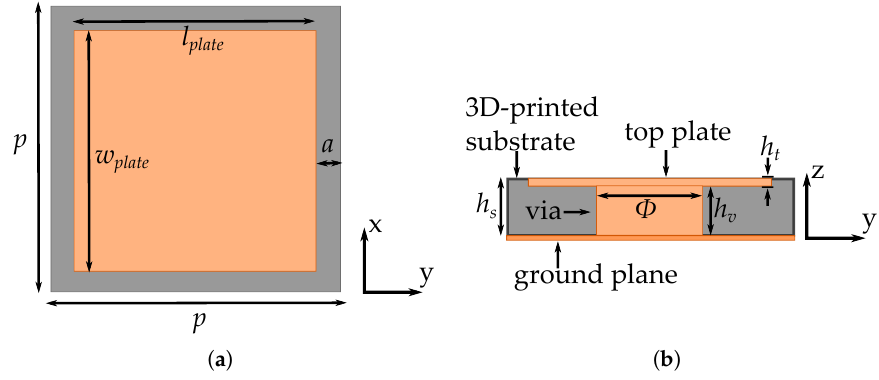
Figure 4. Metasurface unit cell. ( a ) Top-view. ( b ) Cut-view